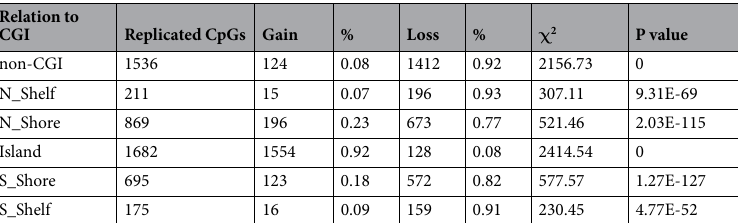
Table 4. Proportion of age-methylated (gain) and demethylated (loss) CpG by location to CGI.